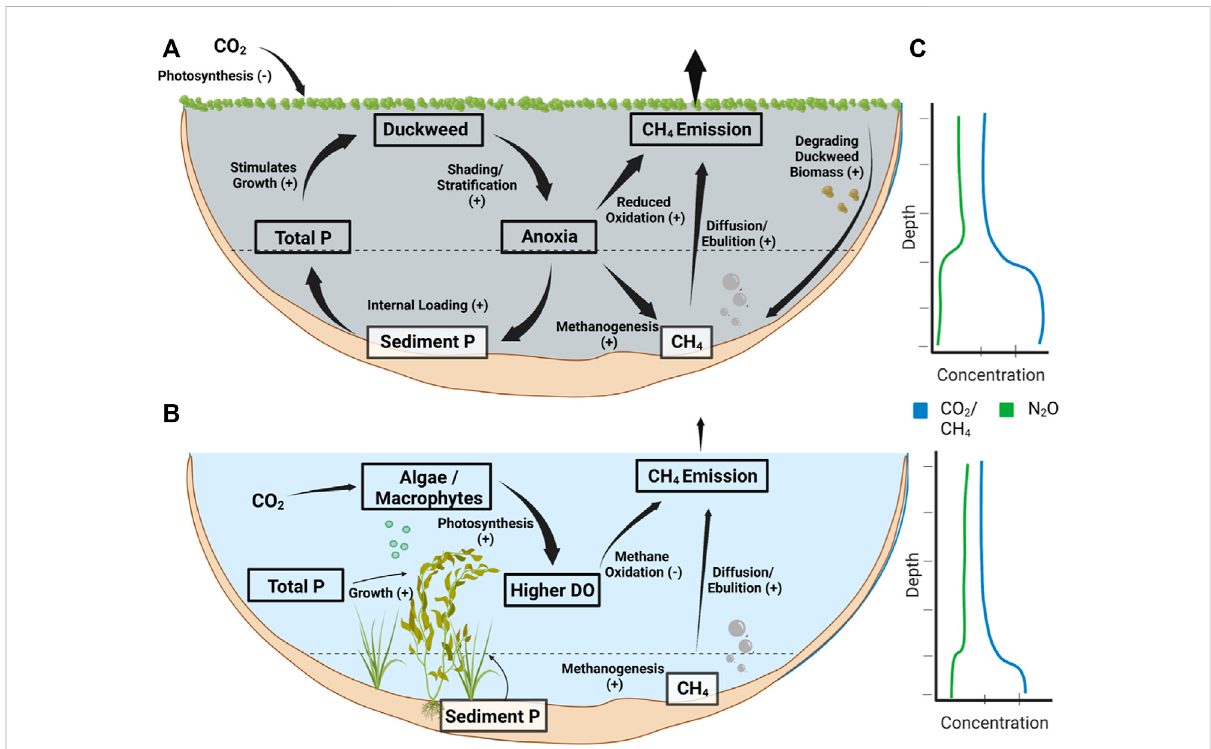
FIGURE 5 A conceptual diagram of the effect of duckweed on pond greenhouse gas emissions. (A) Duckweed can create a positive feedback loop that promotes anoxia, phosphorus loading, and further duckweed growth. While duckweed can consume CO 2 , high phosphorus levels and increased anoxia can promote CH 4 production, reduce CH 4 oxidation, and lead to high CH 4 emissions. (B) Non-duckweed ponds have photosynthesis occurring within the water column, leading to higher DO, more methane oxidation, and less methane production. (C) Conceptual pro fi les of dissolved gases in duckweed and non-duckweed